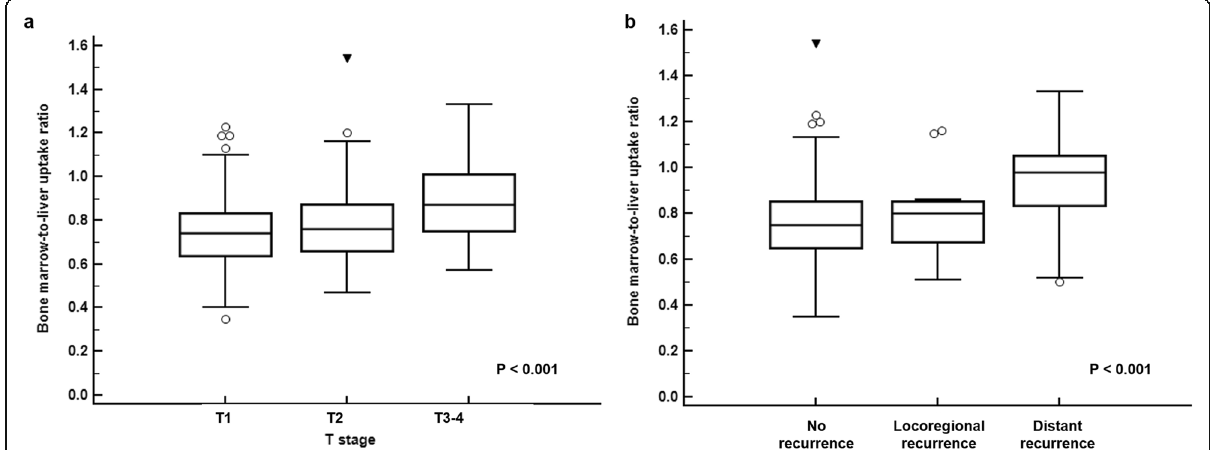
Fig. 2 Bone marrow-to-liver uptake ratio according to T stage ( a ) and recurrence pattern ( b )